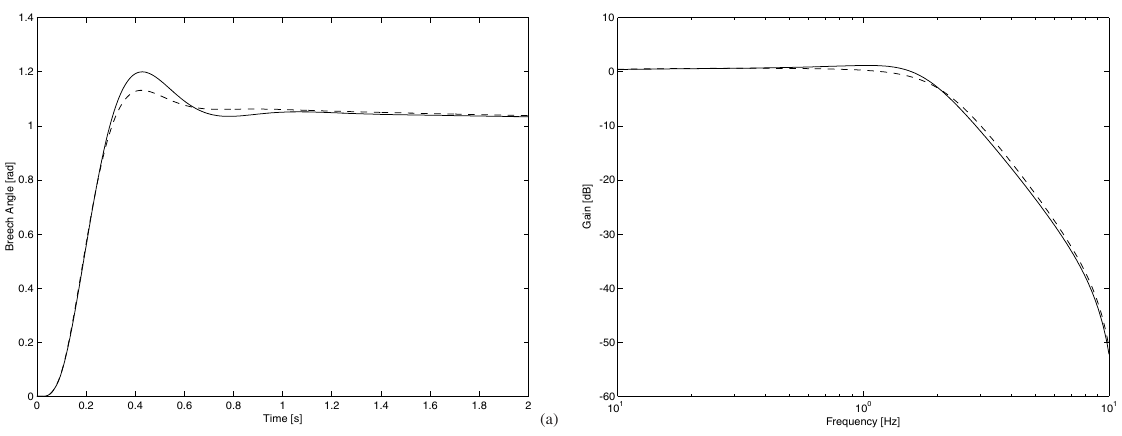
Fig. 5. Plot of closed-loop step (a) and frequency responses (b), with the OOB [solid] and balanced [dash] gun.